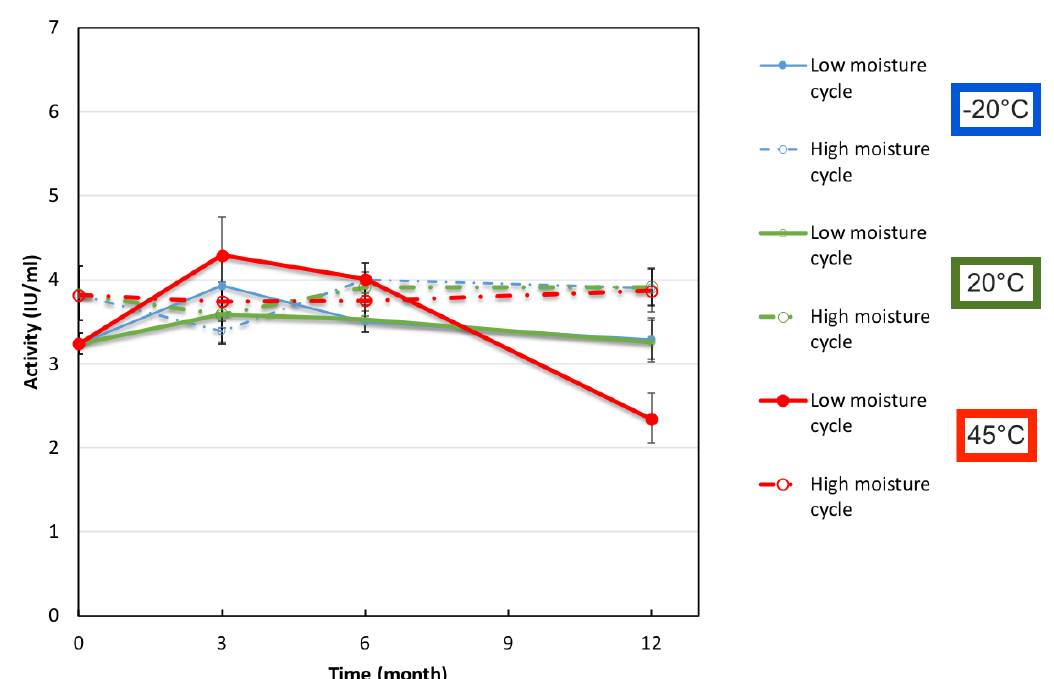
Figure 8. Difference in moisture content for FD IgG (50 mg/mL) between vials with vacuum-oven- dried stoppers and vials with untreated stoppers straight out of packaging after 3 months of storage at −20 ° C and 45 ° C ( n = 3 vial replicates).